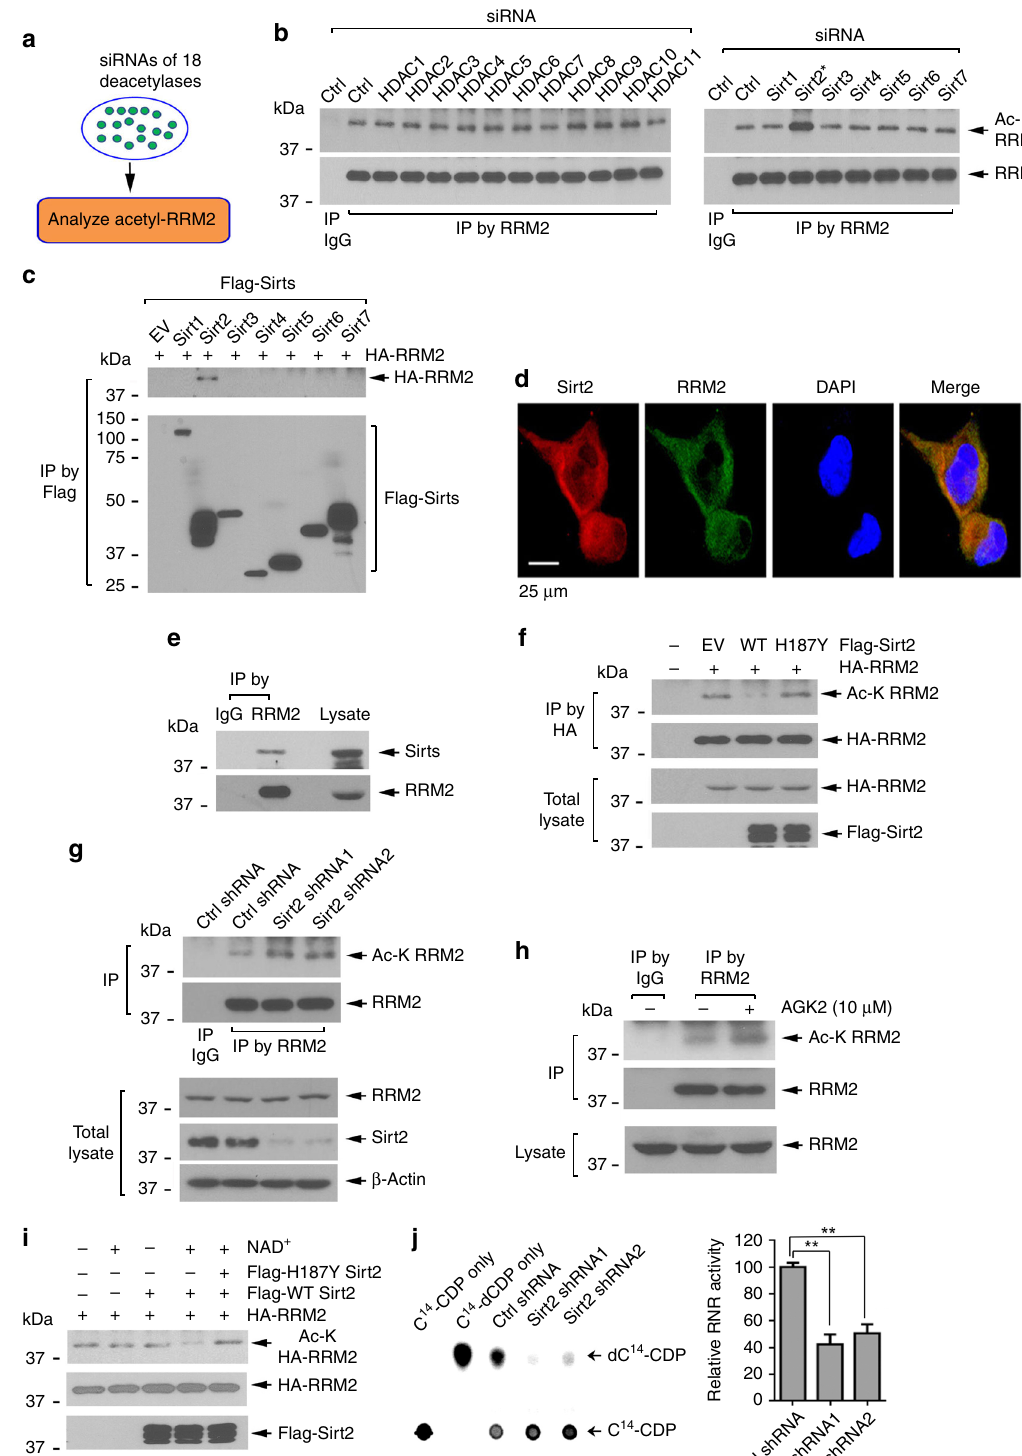
Sirt2 not only co-localized with but also interacted with endogenous RRM2 in H1299 cells (Fig. 4d, e). Intriguingly, signi fi cantly increased co-localization of Sirt2 and RRM2 was observed in the S- phase cells compared with the G1-phase cells (Supplementary Fig. 9). The speci fi city of the Sirt2 antibody used in this experiment was further con fi rmed as shown in Supplementary Fig.